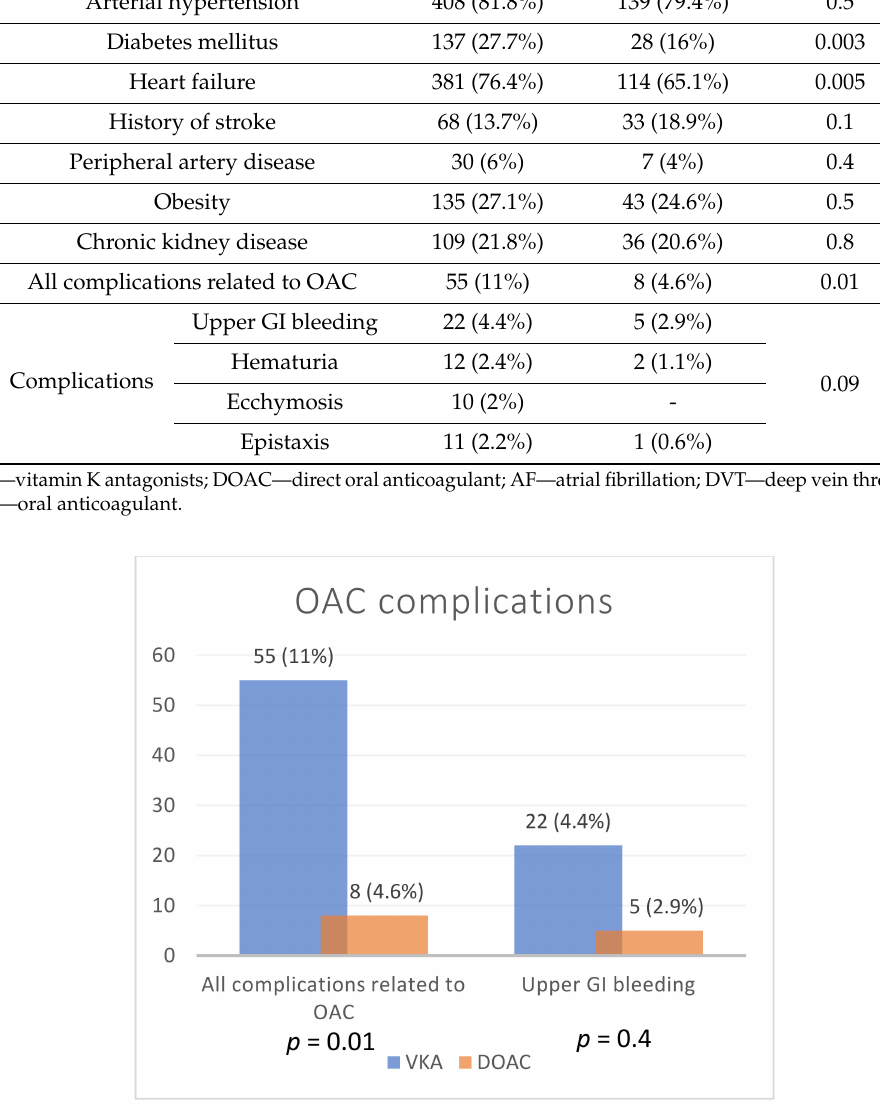
Figure 1. Oral anticoagulant complications. OAC—oral anticoagulants; VKA—vitamin K antagonist; DOAC—direct oral anticoagulant;